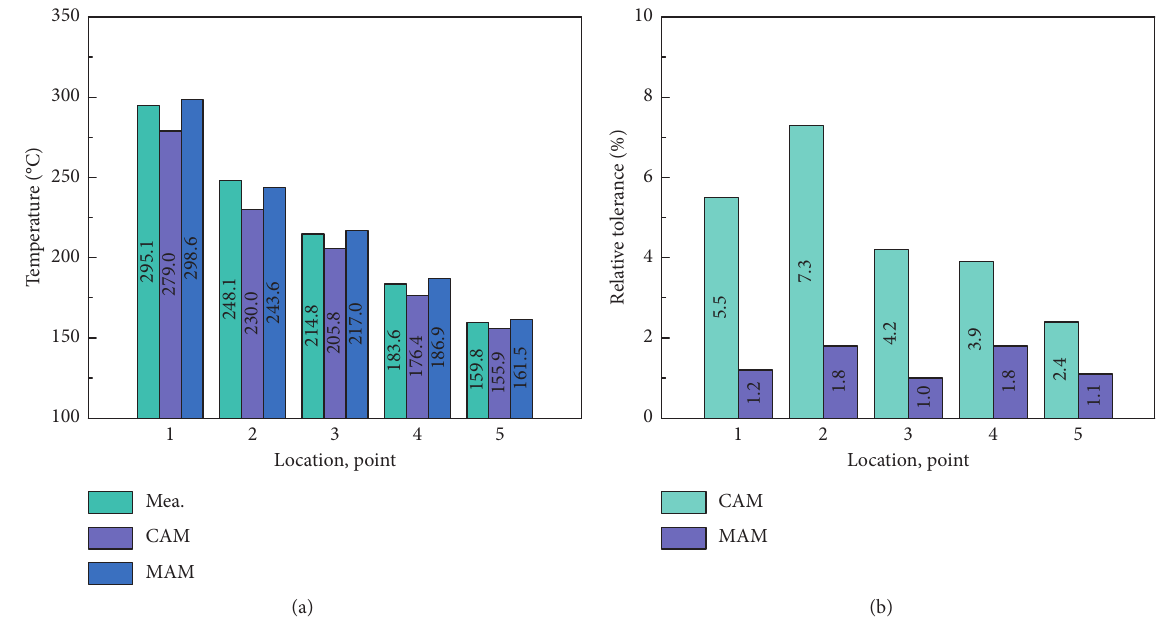
Figure 15: Comparison of the peak temperature and relative tolerance. (a) Peak temperature; (b) relative tolerance.